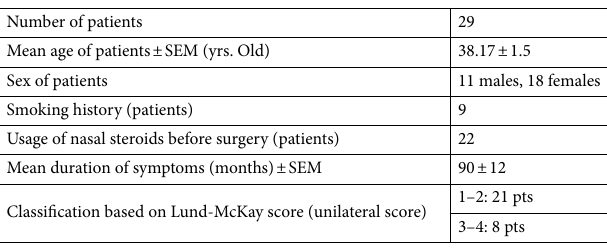
Table 1. Demographic information. SEM, Standard error of the